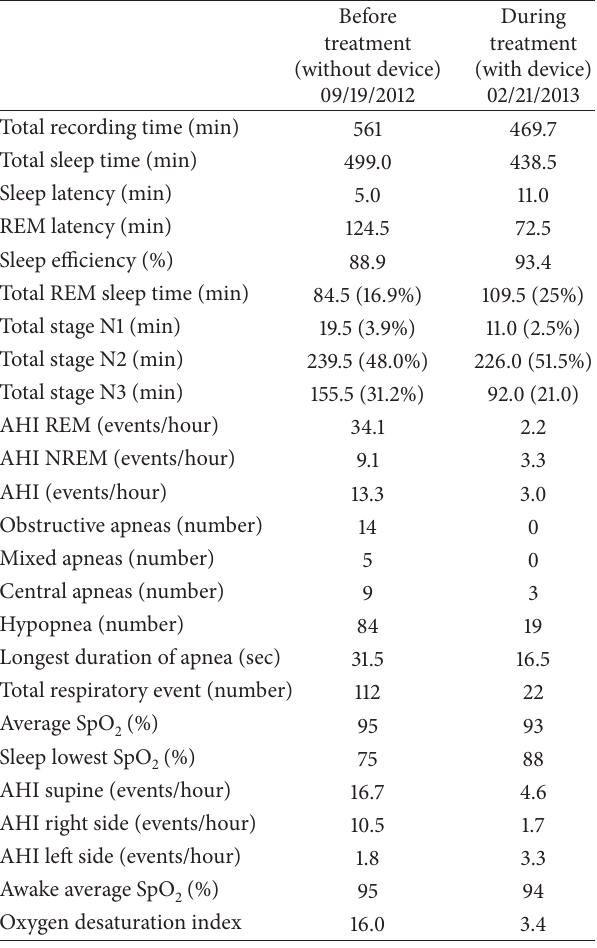
Table 1: Polysomnographic parameters of the